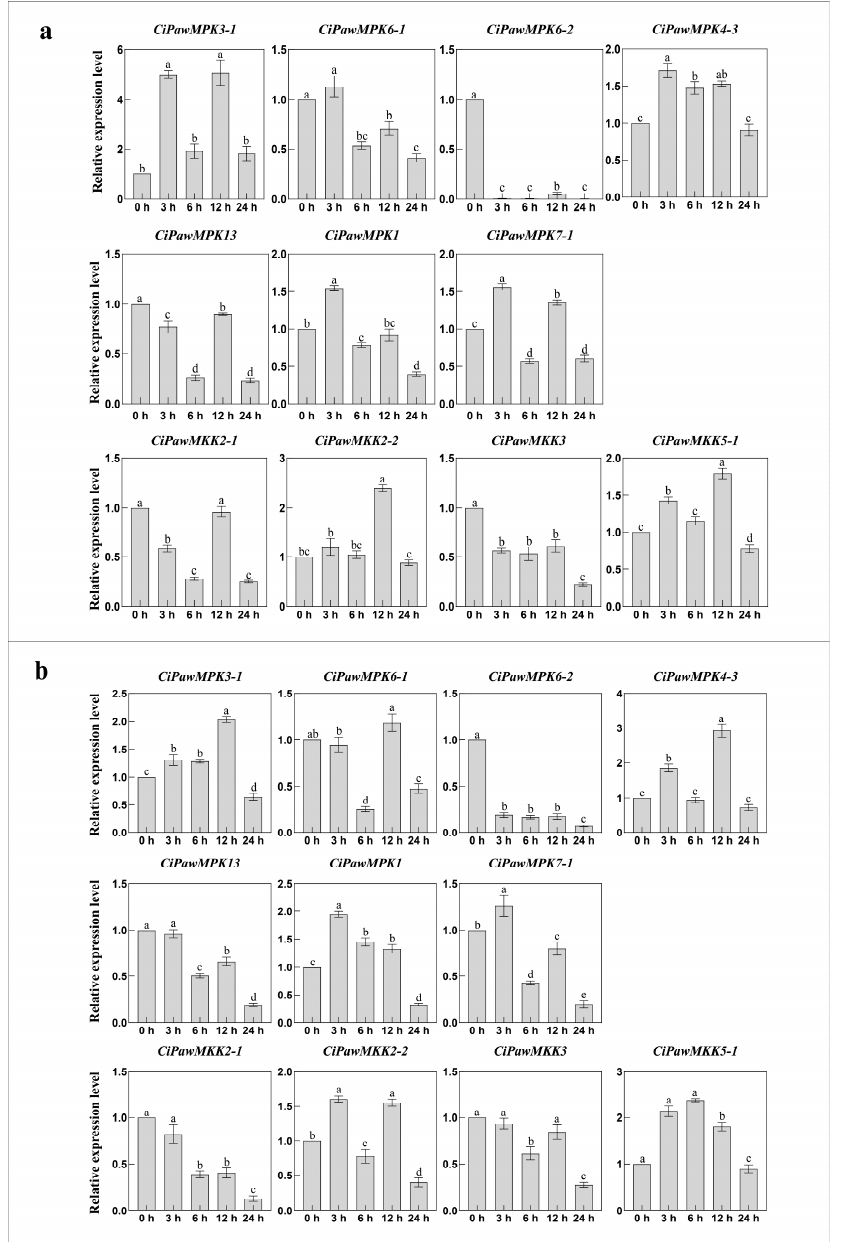
Figure 8. Gene expression patterns of MPK and MKK in pecan under SA ( a ) and ABA ( b ) treatments. The reference gene is the actin gene ( CiPaw.03G124400 ). The horizontal coordinates indicate the different time points sampled and the vertical coordinates indicate the expression level of the genes. According to Duncan’s multiple range test, it was judged whether there was a significant difference in the expression levels at different time points ( p < 0.05), and the difference results were denoted by lowercase letters. Error bars represent mean ± SE obtained from three biological replicates.